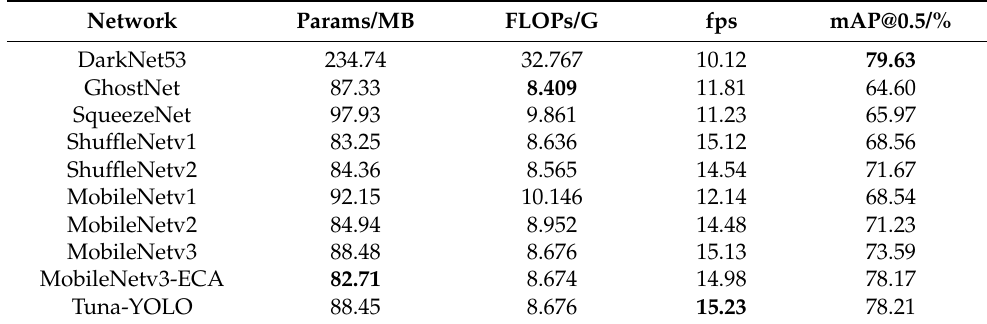
Table 5. Performance comparison of different lightweight networks.